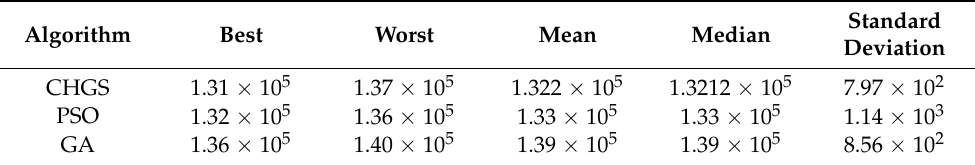
Table 6. Statistical measures of the results of the IEEE 118-bus system obtained with different algorithms over 20 independent runs.